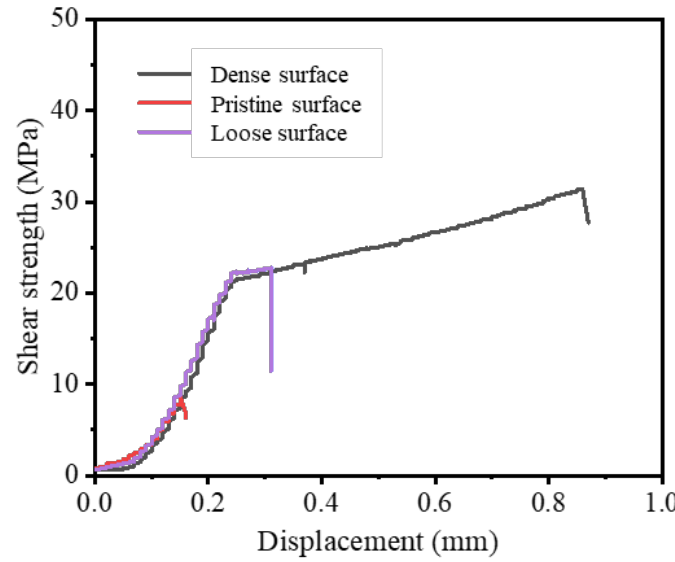
Figure 7. Force–displacement curve of the brazed joint.